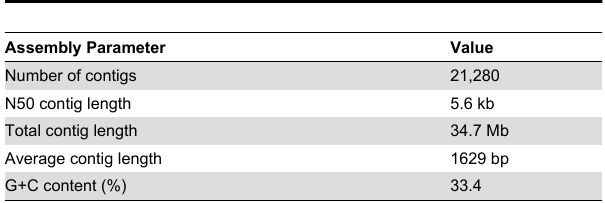
Table 1. Characteristics of QPX genomic